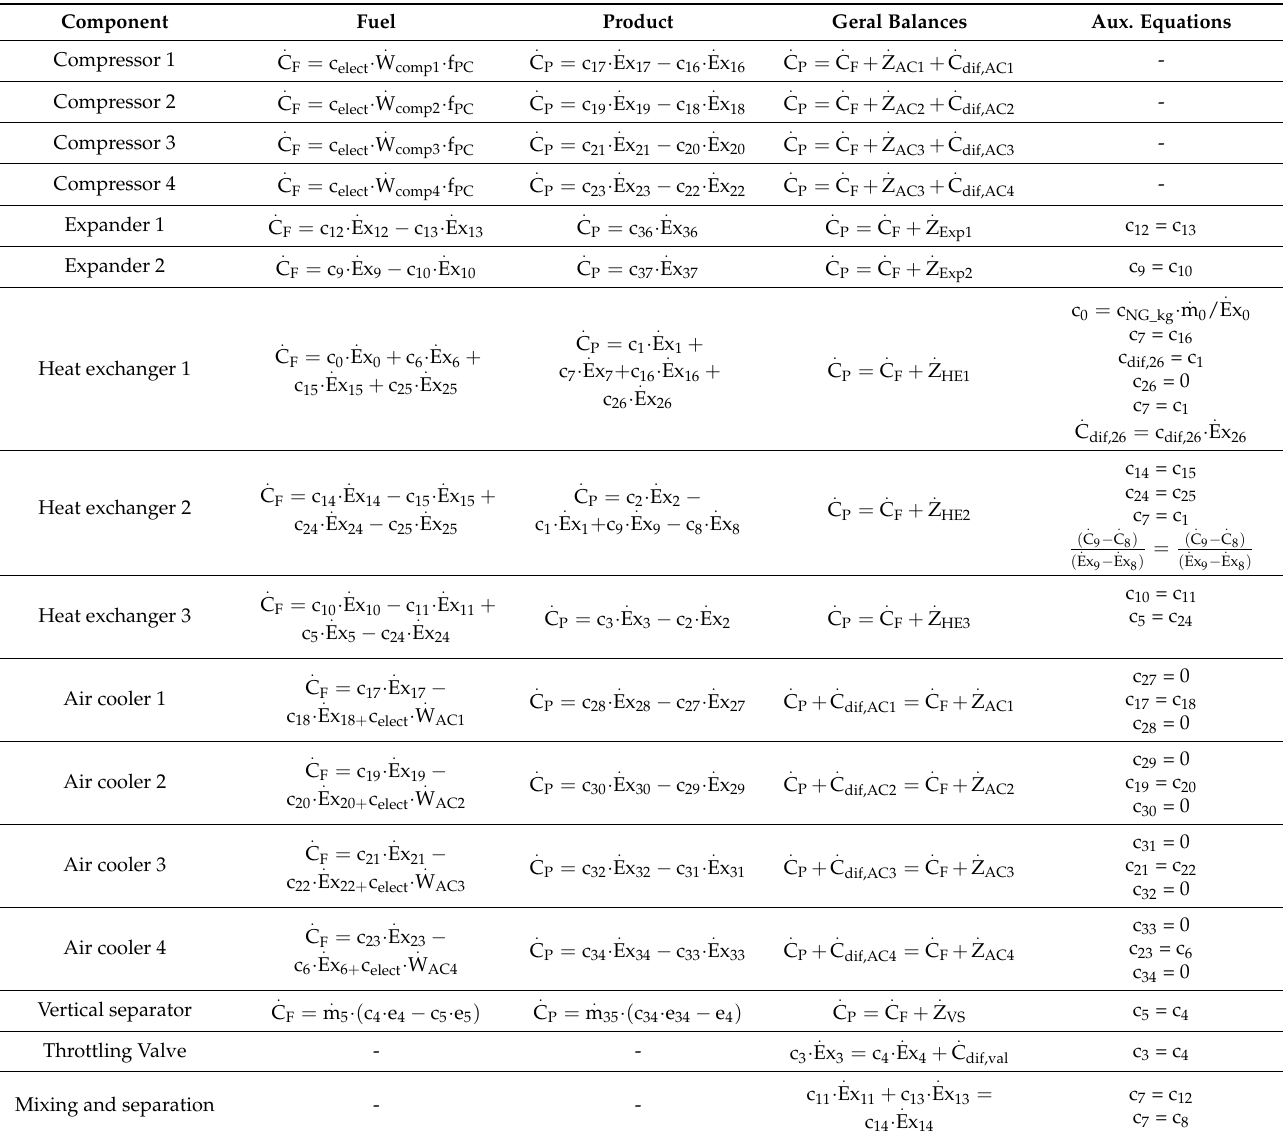
Table 3. Exergoeconomic